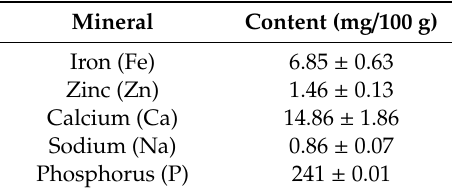
Table 6. Mineral content of teosinte